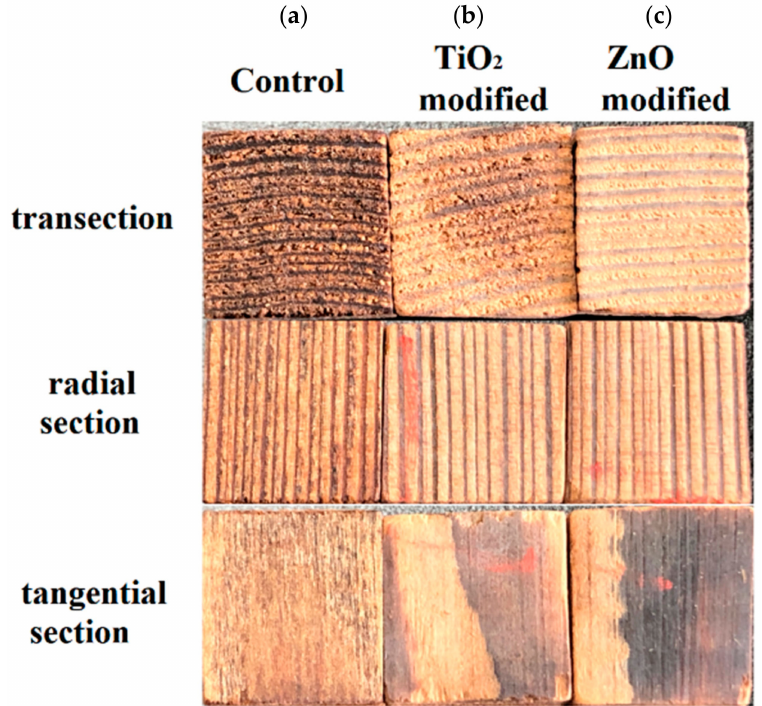
Figure 1. The photos of transection, radial and tangential sections of wood samples: ( a ) Control; ( b ) TiO 2 -modified wood; ( c ) ZnO-modified